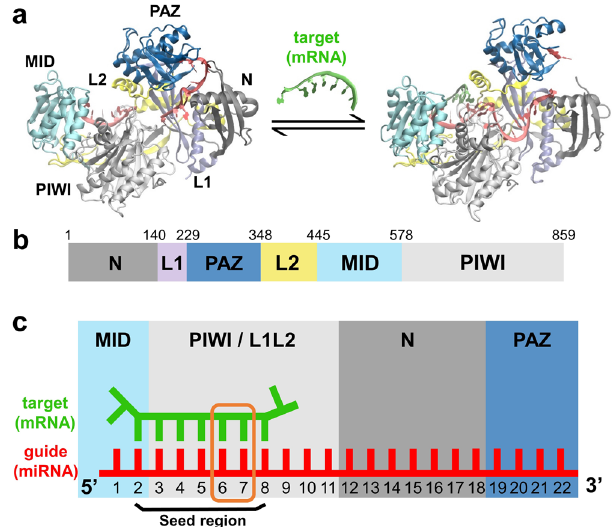
Fig. 1 Function, domain decomposition and structure of the human Argonaute 2 (hAgo2). a Crystal structures of the RISC or hAgo2-miRNA complex (left, PDB ID: 4W5N) and RISC-mRNA complex (right, PDB ID: 4W5O). b Structural domains of hAgo2. c Cartoon illustration of target (mRNA) recognition by guide (miRNA) in hAgo2. The seed region (g2-g8) of guide is the labeled. Recognition at position g6-g7 studied in this work is highlighted in orange